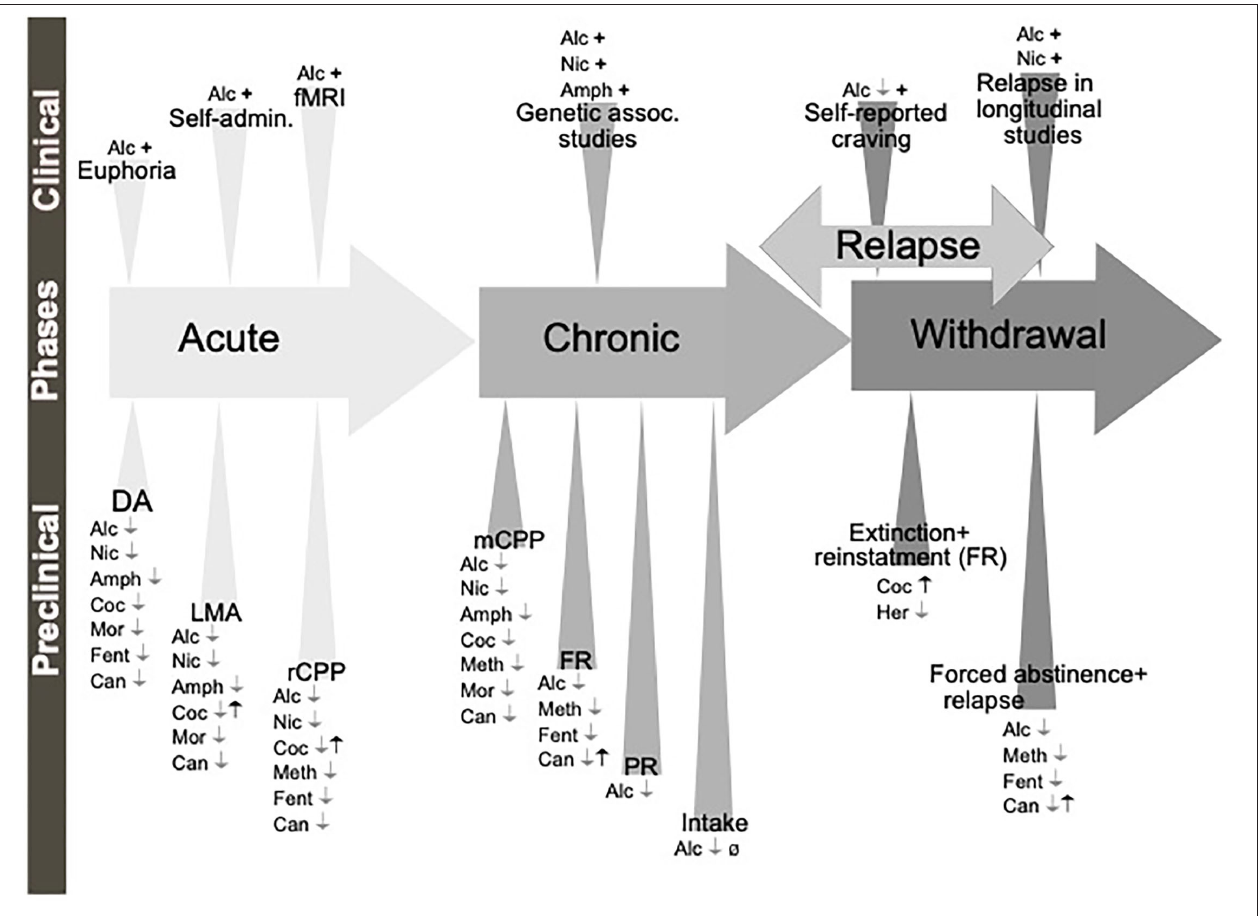
FIGURE 7 | Schematic illustration of the different phases of the addiction cycle which ghrelin and GHSR-1A influence. Ghrelin (black symbols) and GHSR-1A receptor antagonists or reverse agonists (gray symbols) influence behaviors of the addiction cycle, related to alcohol (Alc), nicotine (Nic), amphetamine (Amph), cocaine (Coc), methamphetamine (Meth), morphine (Mor), fentanyl (Fent), heroin (Her) and Cannabinoids (Can). Dopamine release in nucleus accumbens (DA), locomotor stimulation (LMA), reward of conditioned place preference (rCPP), memory of reward in the CPP test (mCPP), motivation in fixed ratio (FR) or progressive ratio (PR) protocols, alcohol or drug intake (Intake), functional magnetic resonance (fMRI). Positive association ( + ), increases/enhances ( ↑ ), decreases/attenuates ( ↓ ), conflicting evidence or no effect (Ø) on drug